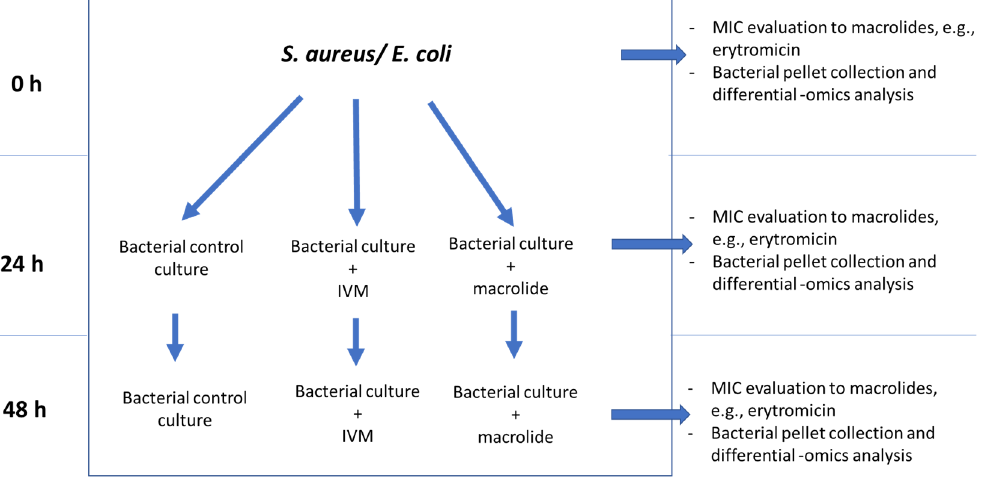
Figure 1. Experimental design for the evaluation of the effects of IVM therapeutic dose exposure in Gram-positive, Gram-negative, and mycobacteria.